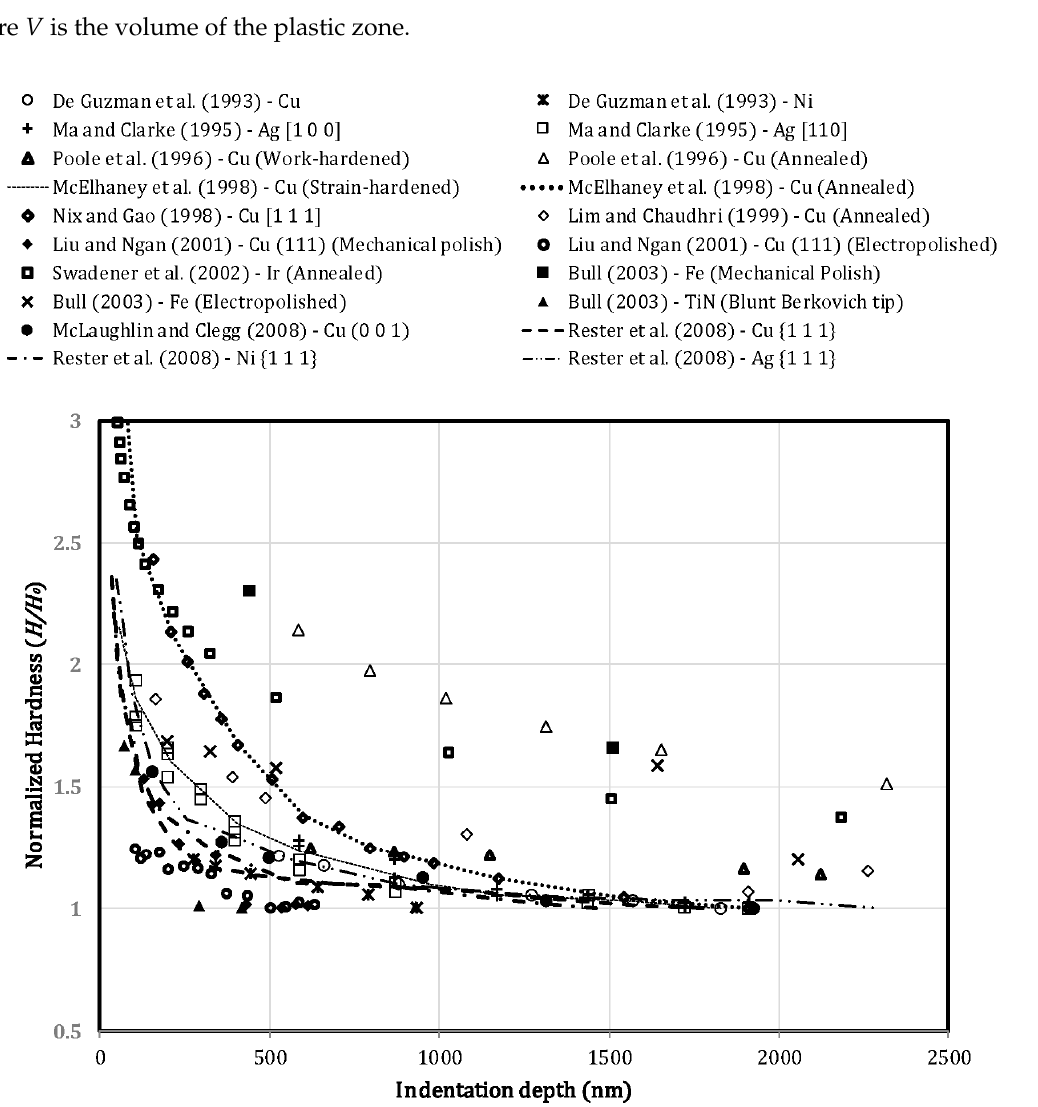
Figure 1. Size effect during nanoindentation. The original experimental data have been reported by De Guzman [12], Ma and Clarke [91], Poole et al. [92], McElhaney et al. [93], Nix and Gao [13], Lim and Chaudhri [15], Liu and Ngan [94], Swadener [14], Bull [20], McLaughlin and Clegg [95] and Rester et al.